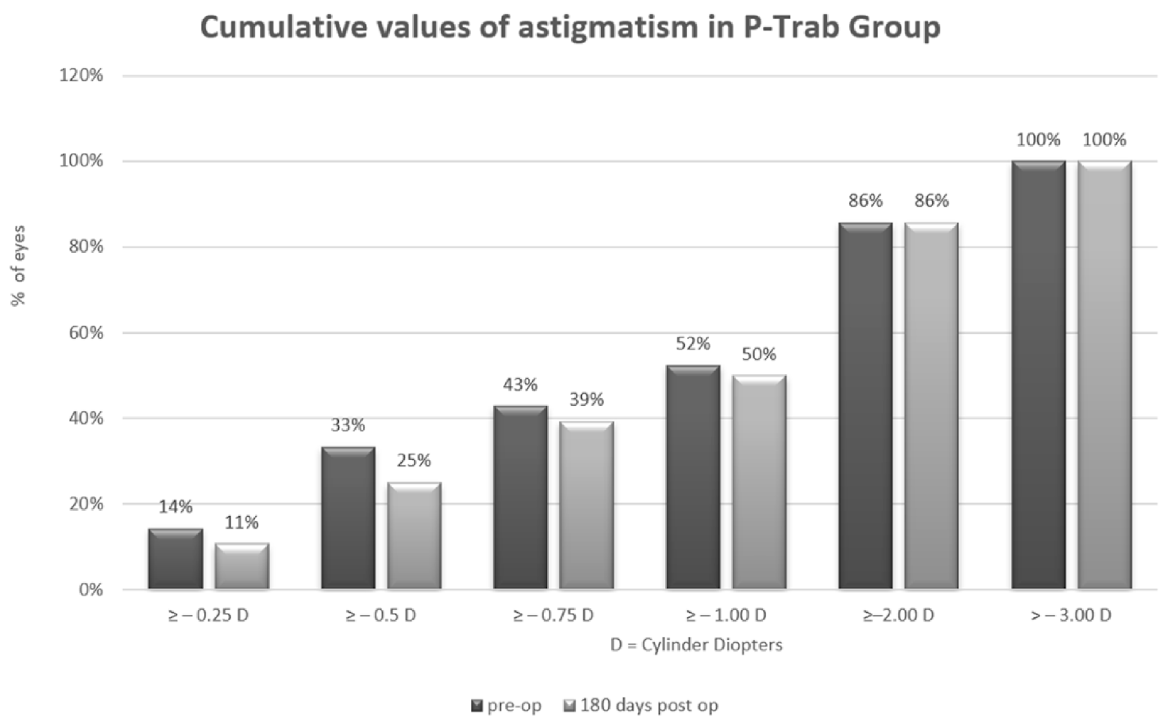
Figure 1. Cumulative values of astigmatism in the P-Trab group.